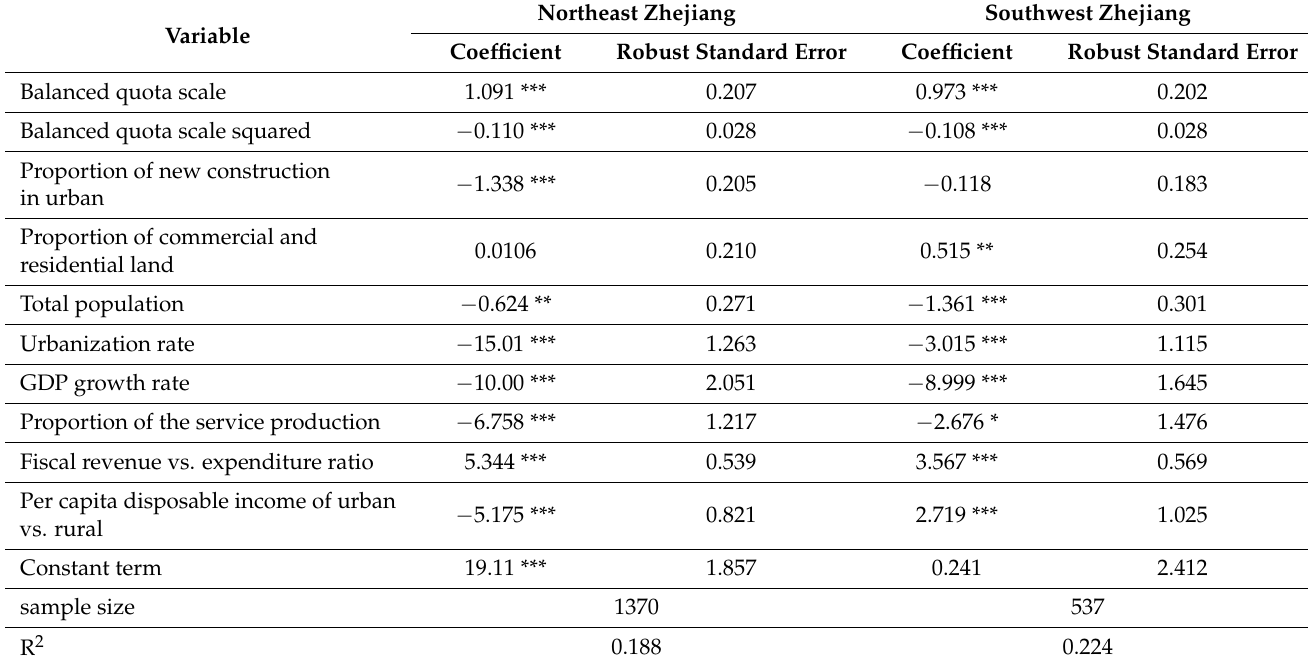
Table 4. Estimated results of the spatial heterogeneity of the scale and revenue in Zhejiang IVDB